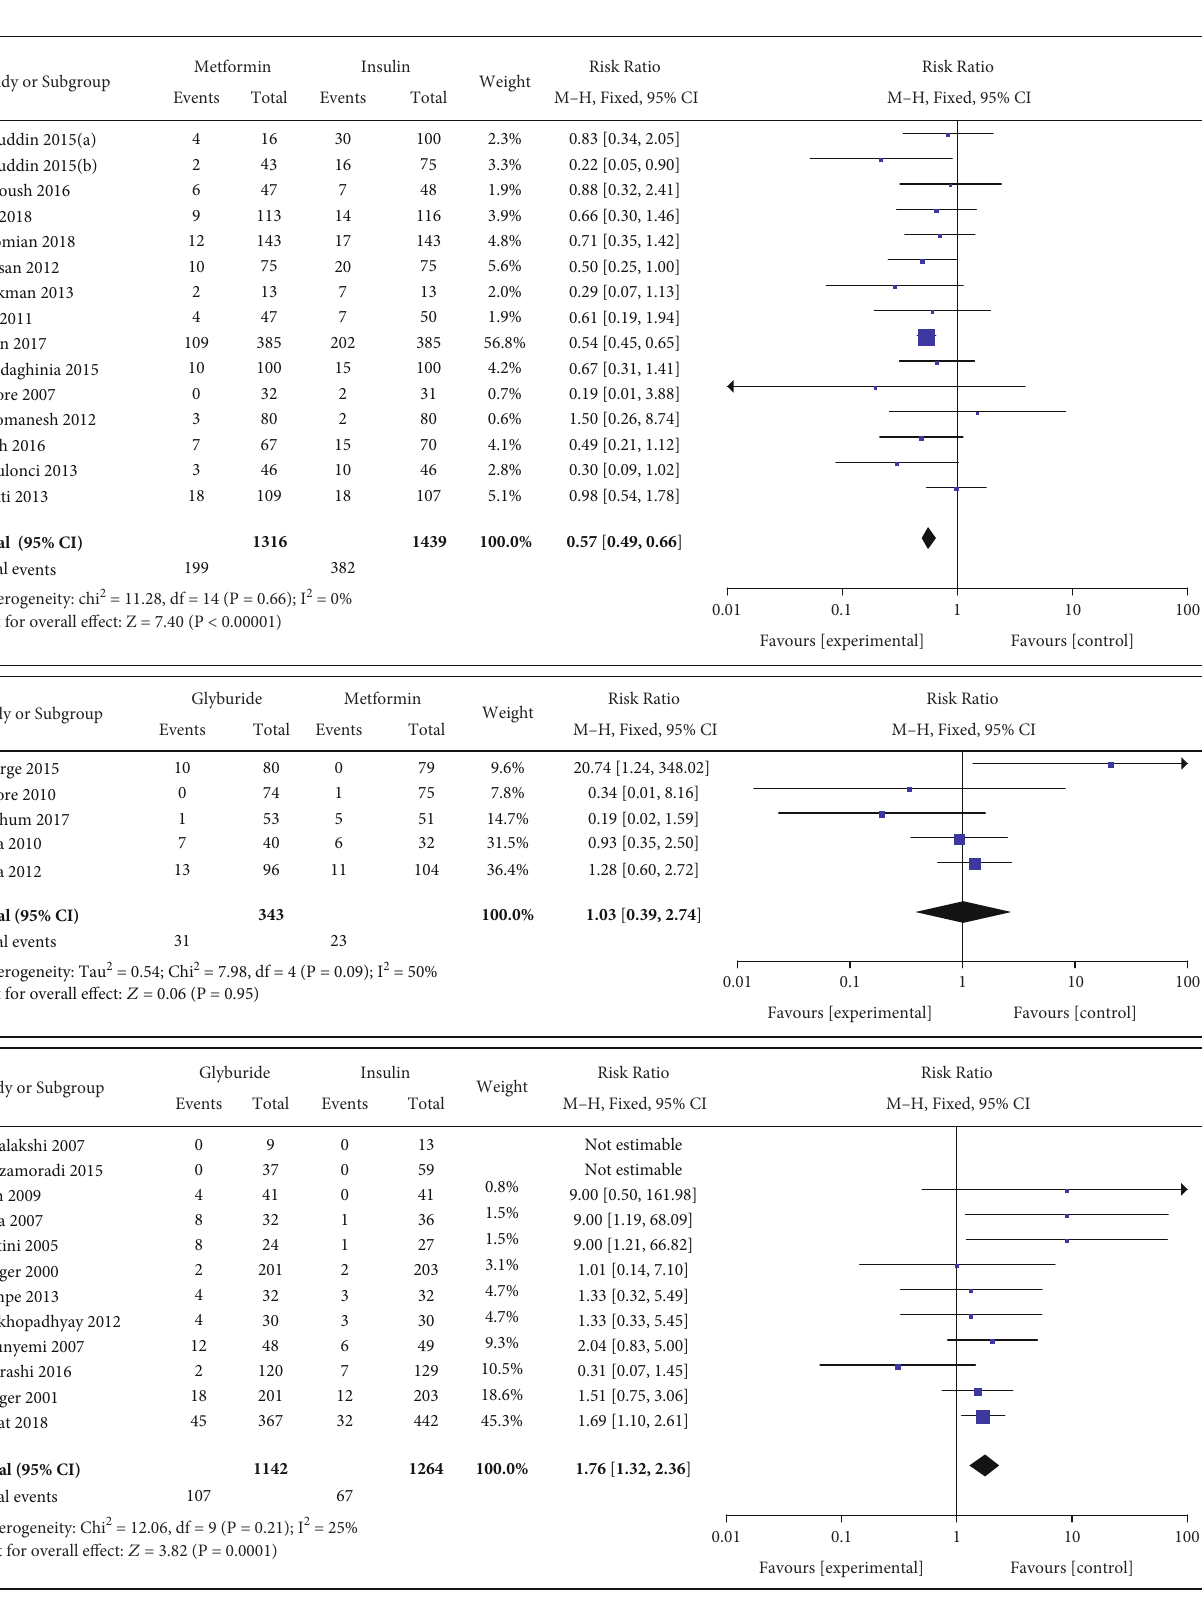
Figure 15: Neonatal